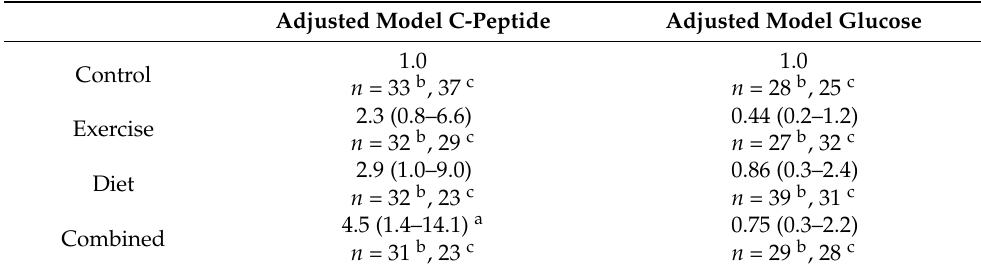
Table 4. Odds ratio (95% CI) for C-peptide and glucose changing from clinically abnormal at baseline to normal at 12-month follow-up. Normal C-peptide and glucose range were 0.78–1.89 ng/mL and <100 mg/dL,